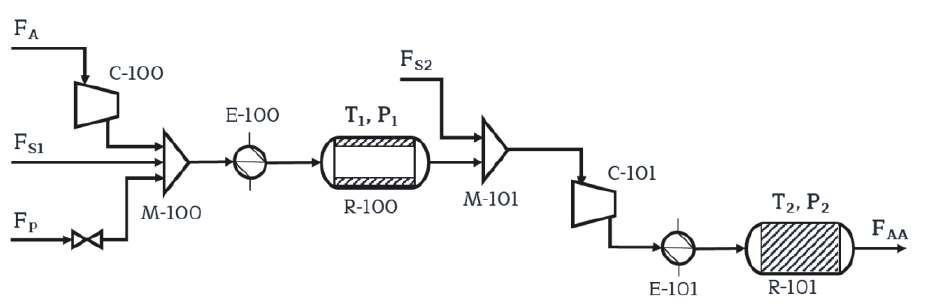
Figure 1. Process flow diagram of the two-reactor section of the production of acrylic acid.